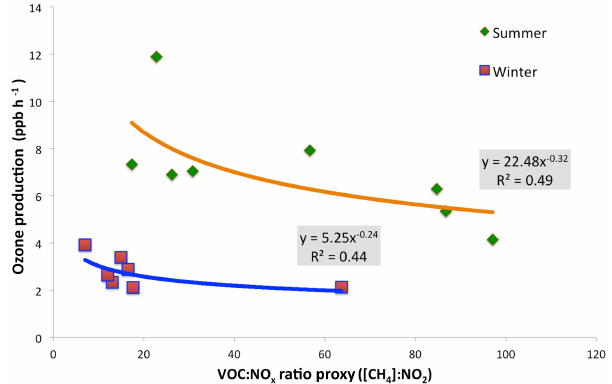
Figure 10. Plot of measured ozone production from the DISCOVER-AQ campaign near Fresno during winter (maroon squares) and from the ArvinO3 study during the summer (green diamonds) vs. a proxy of the VOC:NO x ratio estimated by the measured CH 4 enhancement over global background divided by the NO x measured during the flights from the CARB air quality moni- toring network